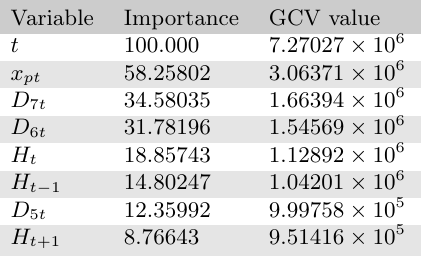
Table 2: Important predictor variables according to the MARS